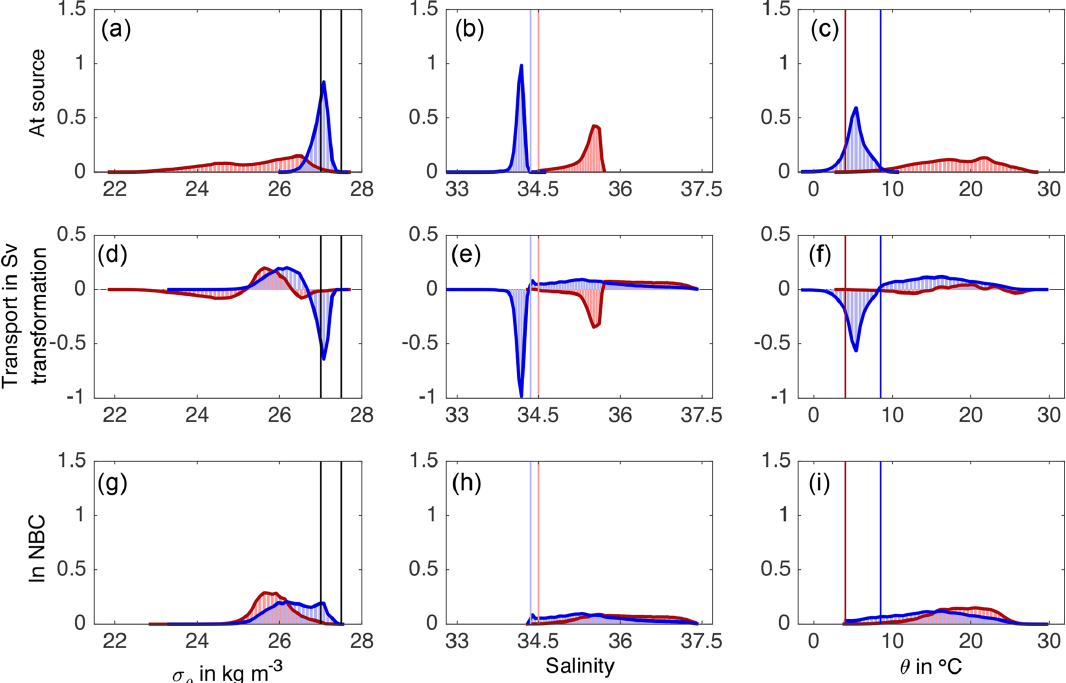
Figure 10. Mean property modification of waters with AC and DP origin that enter the mixed layer at least once during their transit. Mean volume transport per density ( a, d, g , 0.1kgm − 3 bins), salinity ( b, e, h , 0.05 psu bins), and temperature ( c, f, i , 0.5 ◦ C bins) class at source region (a–c) and in NBC (g–i) , as well as volumetric property transformation (d–f) for waters of AC (red bars) and DP (blue bars) origin. From all 10 REF experiments only particle trajectories with at least one mixed layer contact during their transit are considered. Potential density levels used to separate upper, intermediate, and deep waters are highlighted by solid black lines; light blue (red) lines mark S values that constitute the upper (lower) limit for 95% of the DP (AC) waters; dark blue (red) lines mark θ values that constitute the upper (lower) limit for 99% of the DP (AC) waters (see Fig.